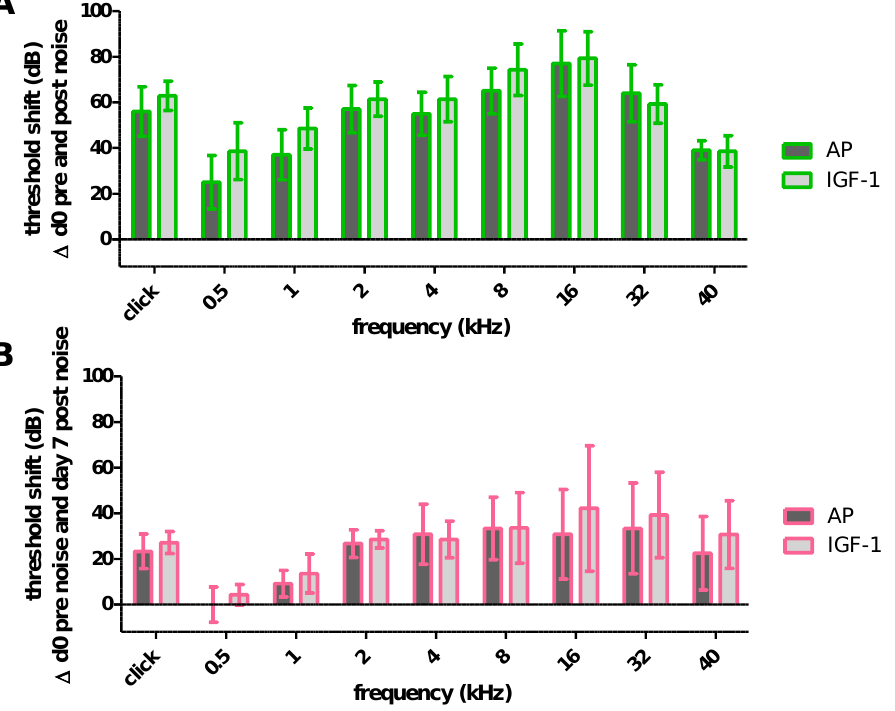
Figure 5. Noise-induced threshold shifts of the contralateral ears of both treatment groups (AP (dark (AP (dark grey) and IGF-1 (light grey). Neither 30 min ( A ) nor one week after noise trauma grey) and IGF-1 (light grey). Neither 30 min (A ) nor one week after noise trauma (B ) there are sig- ( B ) there are significant differences between both groups. Mean and SD are nificant differences between both groups. Mean and SD are plotted.